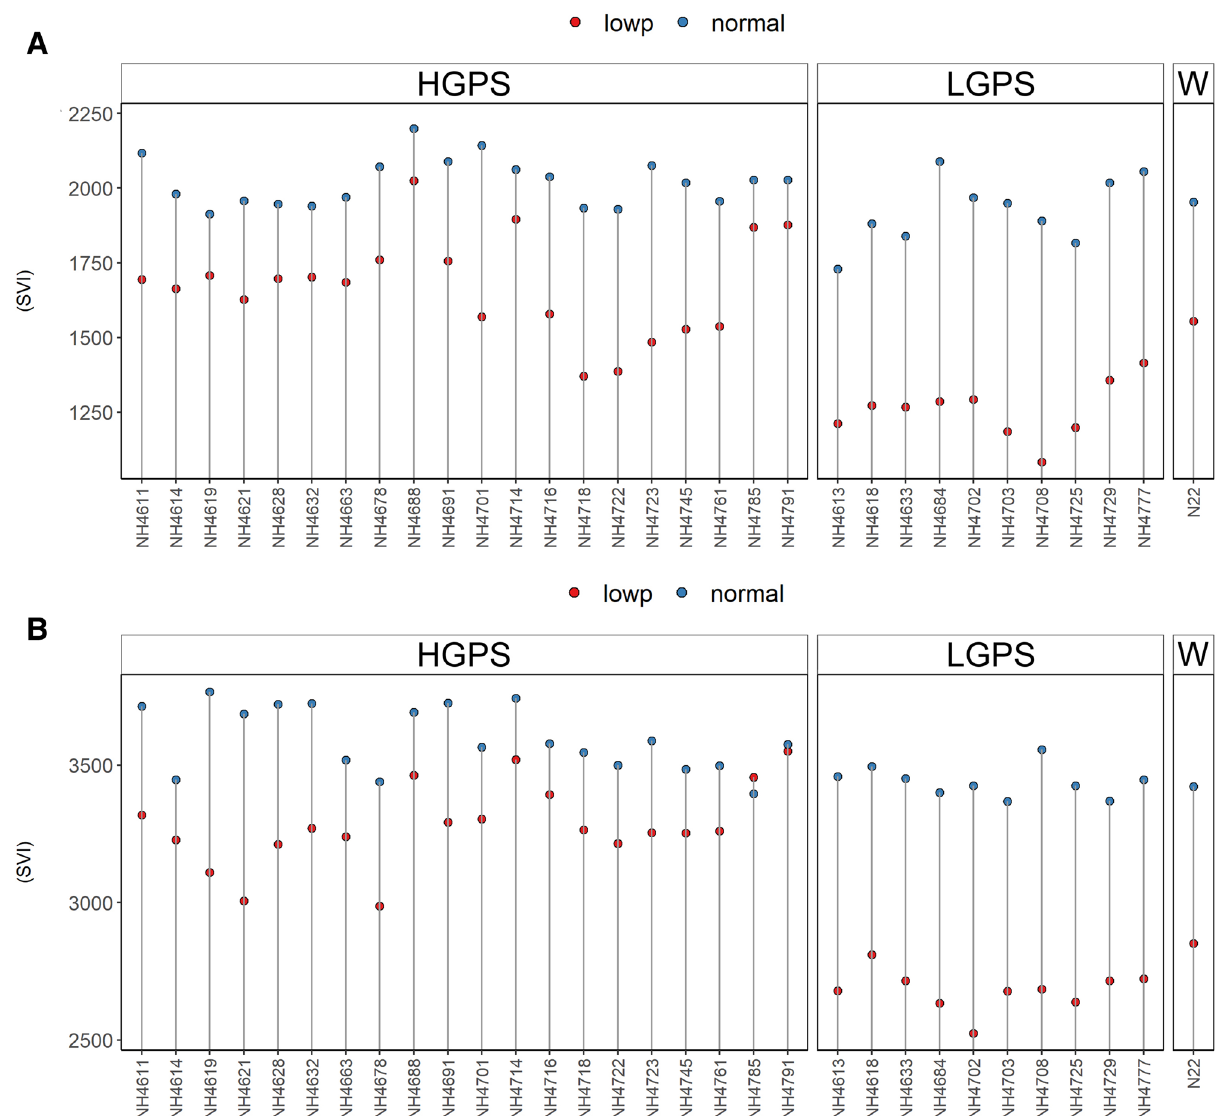
Figure 6. Seedling vigour index (SVI) of seedlings obtained from germination of seeds harvested from low P (shown as red dots) and normal P (shown as blue dots) fields. Wild type N22 (W), high grain P mutant seedlings (HGPS), and low grain P mutant seedlings (LGPS) were grown under normal P condition. ( A ) SVI at 12 days of germination. ( B ) SVI at 24 days of germination. The values represent the mean of 100